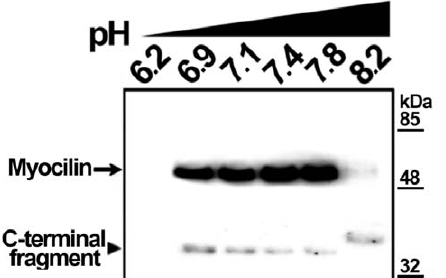
Figure 6. Effect of pH on myocilin proteolytic processing in bicarbonate-free medium. HEK-293T cells (200000 cells/plate) were transfected with a cDNA construct encoding myocilin-myc. After transfection, cells were cultured in bicarbonate-free medium, buffered at different pH values with HEPES. Cells were cultured in a humidified room air atmosphere at 37 u C. Culture media were collected 48 h later and recombinant myocilin present in the culture medium was analyzed by 10% polyacrylamide SDS-PAGE and Western blot using an anti-myc monoclonal antibody. Equal amount of total protein was loaded into each